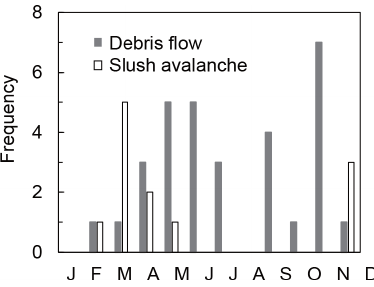
Figure 7. Monthly frequency of debris flows and slush